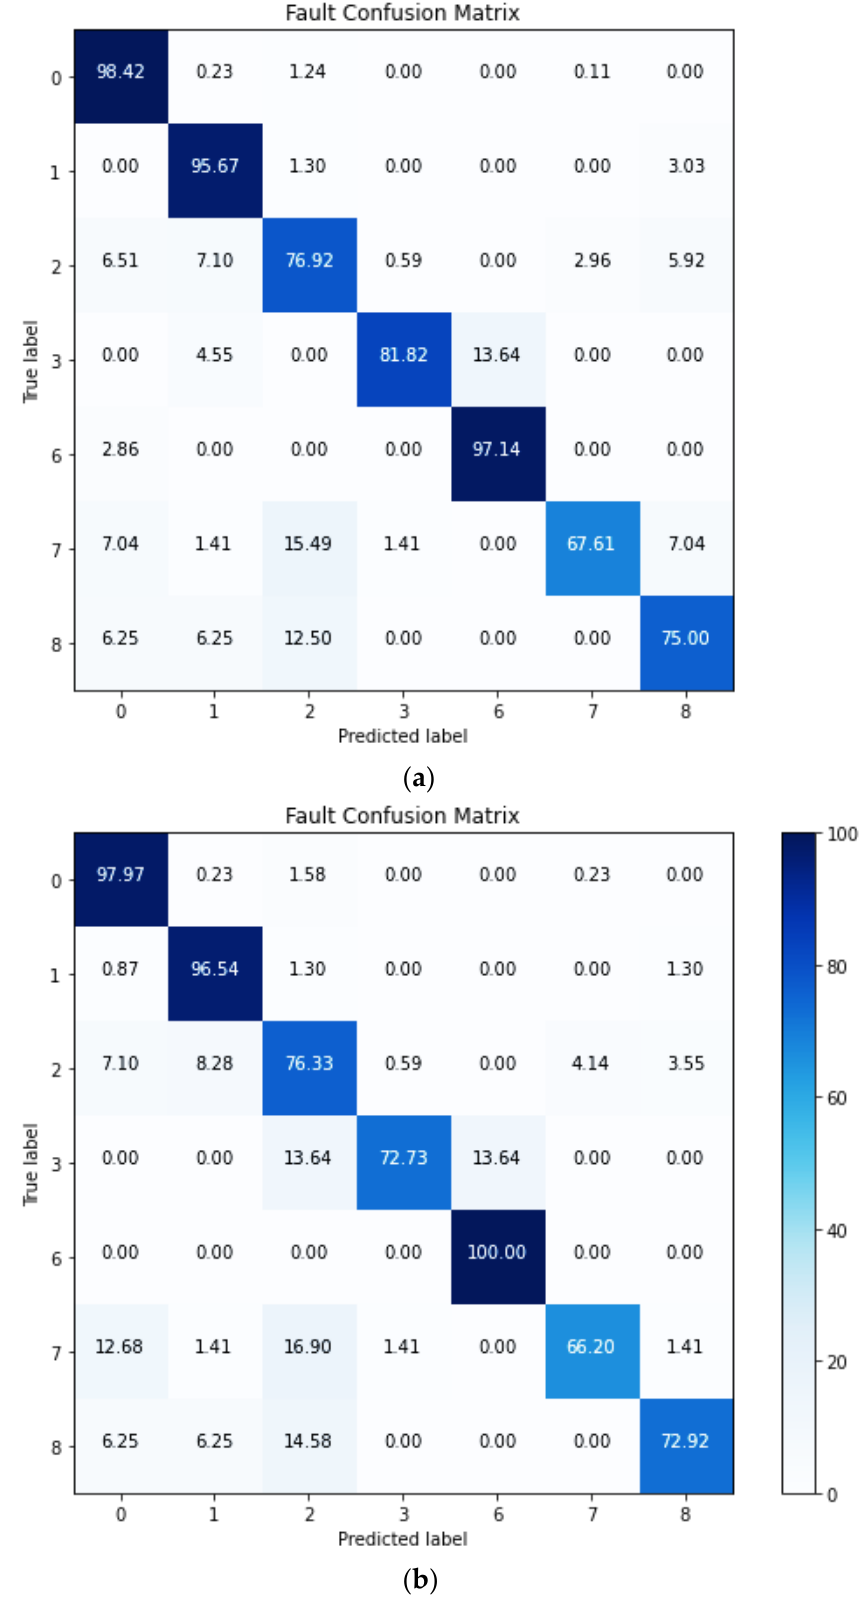
Figure 9. Confusion matrices of the three best-performing classifiers trained on all fault data; ( a ) Neural Network, and ( b ) Random Forest.